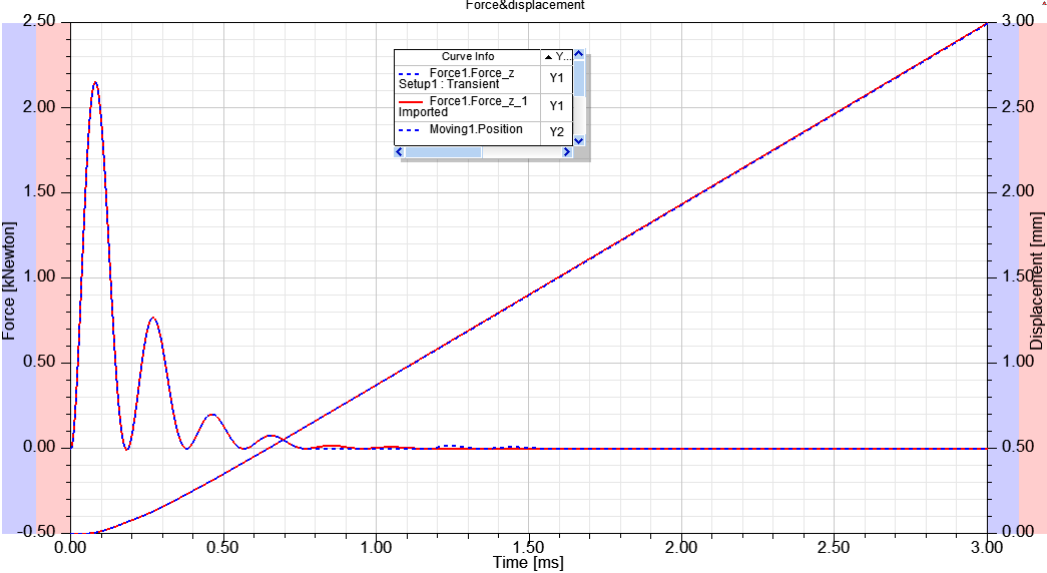
Figure 10. Resultant forces and displacements in continuous and discontinuous energy transfer (Case 1 from Table 2).